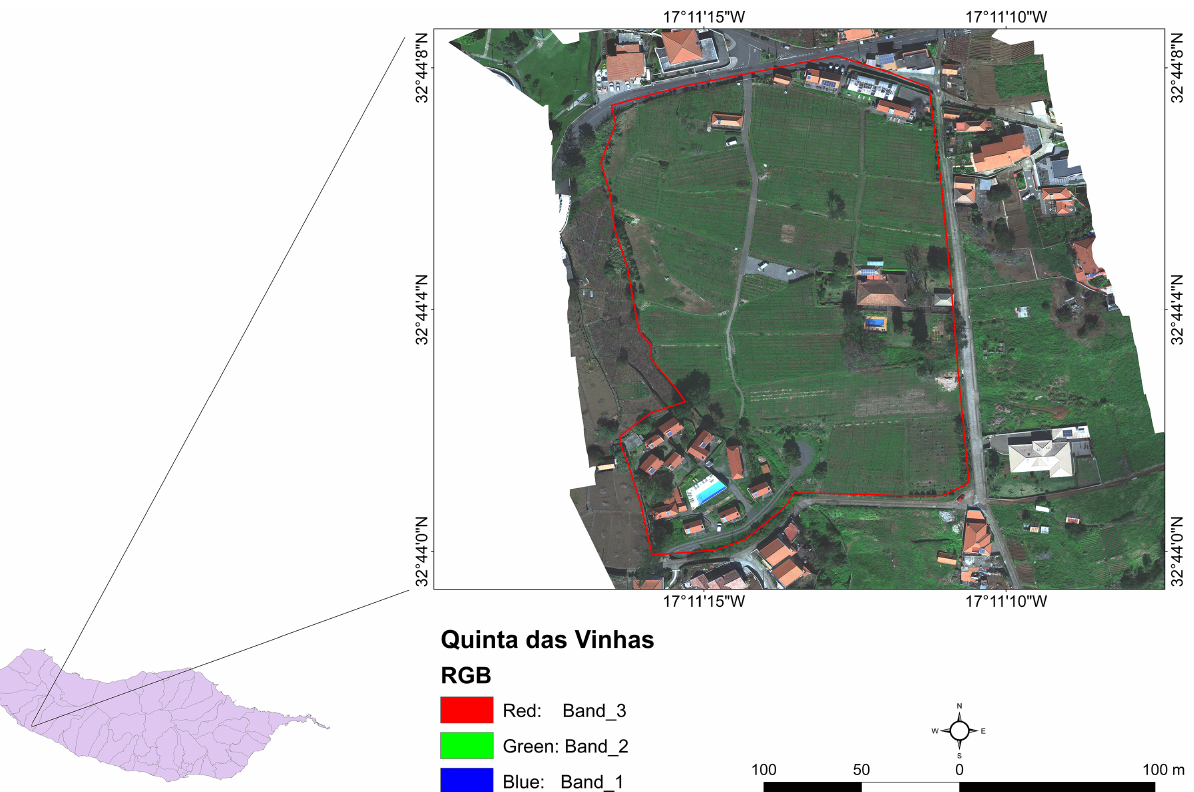
Figure 1. Orthophoto map showing the location of the Quinta das Vinhas ( QV ) agrosystem case study.